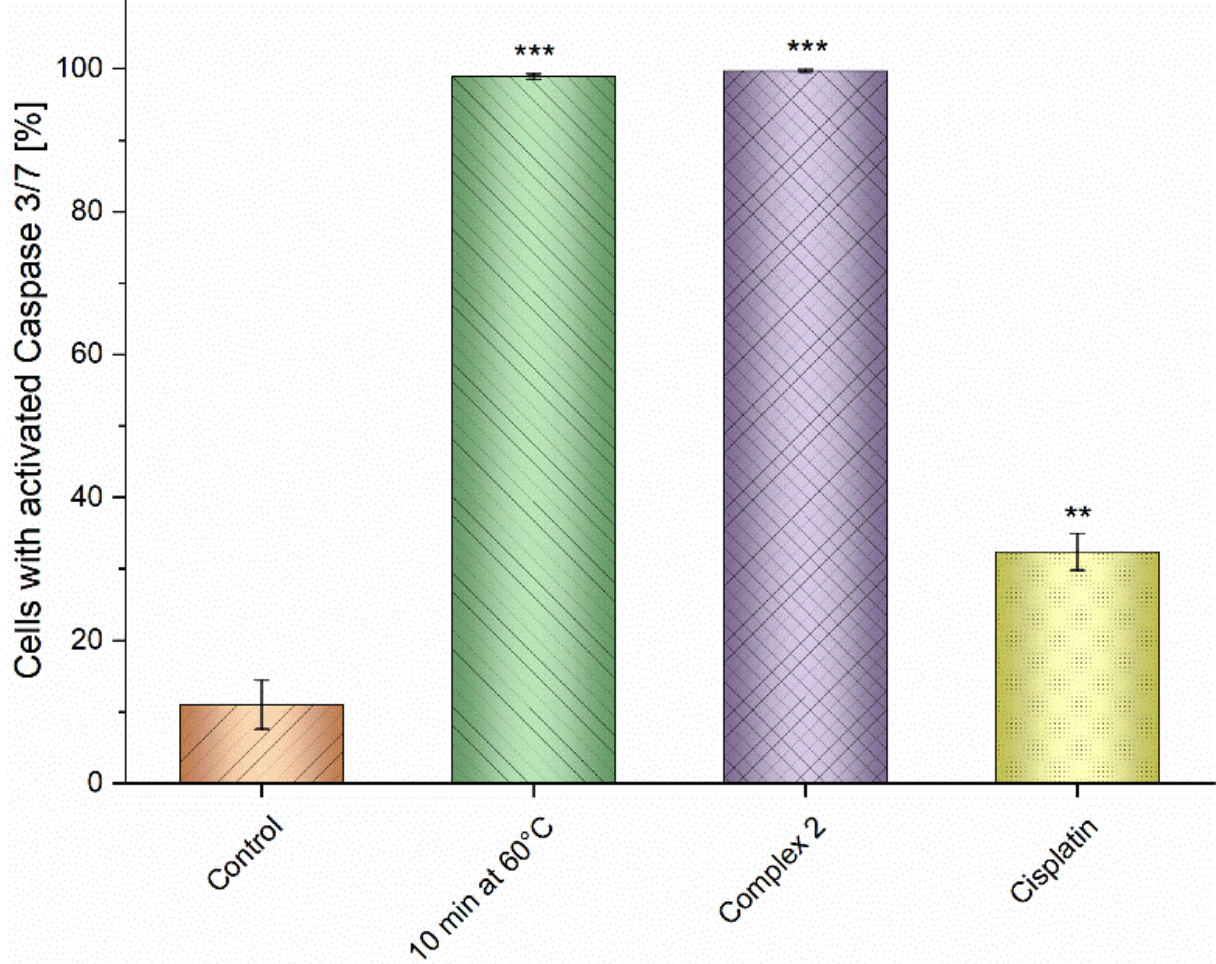
Figure 7. Activation of caspases 3/7 by complex 2 (applied at 3 µ M) and cisplatin applied to the A2780 cells at a 19 µ M concentration after 24 h of incubation. The significant change in the number of cells with activated caspases 3/7 compared to the untreated control is symbolized by ** at p ≤ 0.01 level, and *** at p ≤ 0.005 level.